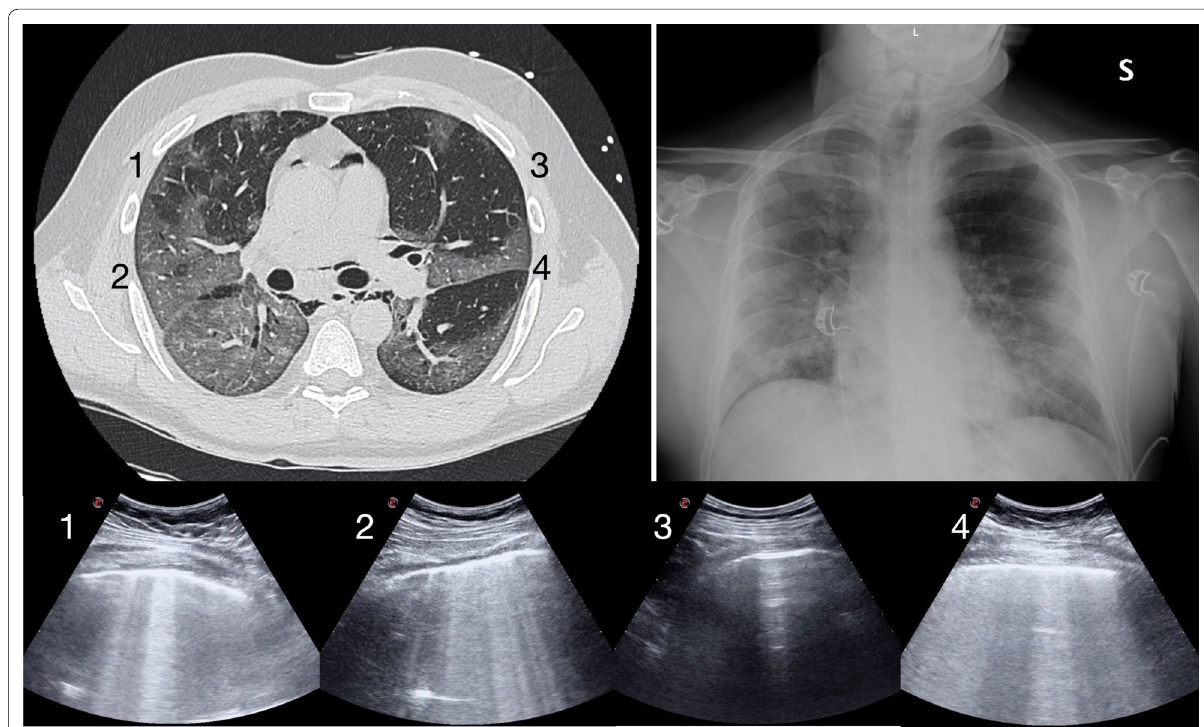
Fig. 2 The case of an otherwise healthy 46-year-old man complaining of fever, cough and dyspnea for 7 days ( severe phenotype ). LUS and CXR were in agreement. LUS showed a high probability pattern for COVID-19 pneumonia. The LUS scans reported in the bottom panel show a patchy and bilateral distribution of clusters of B-lines and light beam (1, 2, 4), alternating with normal A-lines pattern (3). CXR in the upper right panel was read typical for the presence of bilateral GGO and reticular alterations. The corresponding CT scan in the upper left panel shows multiple GGO alterations that were considered typical appearance . The points numbered in the CT image correspond to the 4 LUS scans. RT-PCR was positive. Unfortunately, the patient died of COVID-19 after 20 days from admission. LUS Lung Ultrasound, CXR Chest Radiography, COVID-19 Corona Virus Disease 2019,